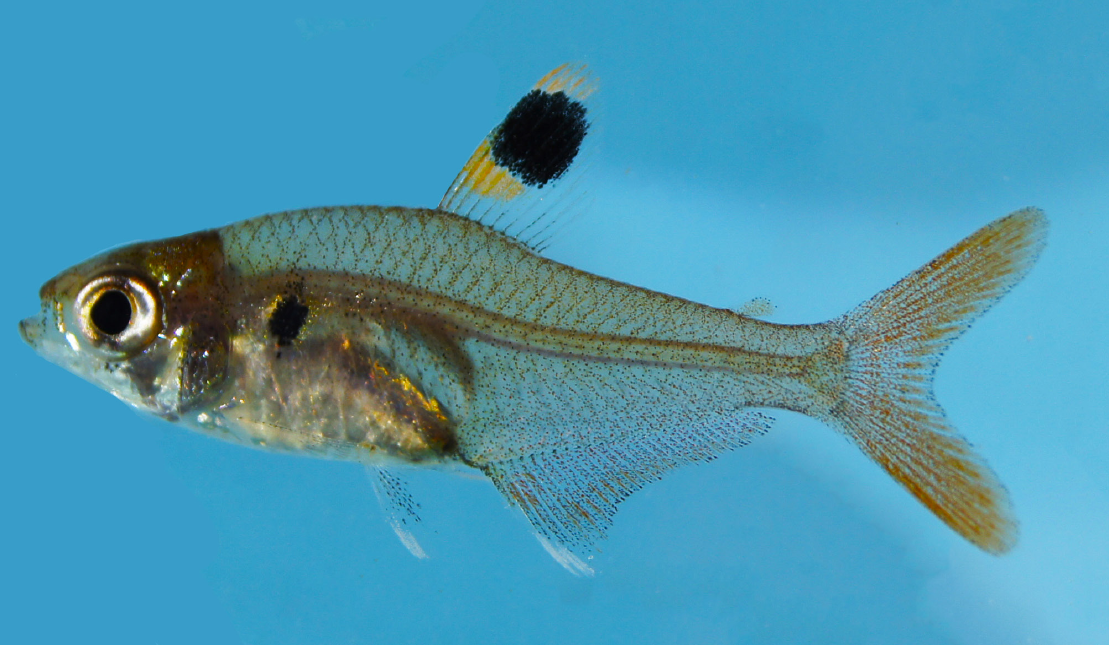
Fig. 5. Hyphessobrycon geryi Guimarães, Brito, Bragança, Katz & Ottoni sp. nov . , paratype (CICCAA 02348), 22.7 mm SL; Brazil: Maranhão State: Lower Tocantins River basin; living specimen photographed immediately after collection.